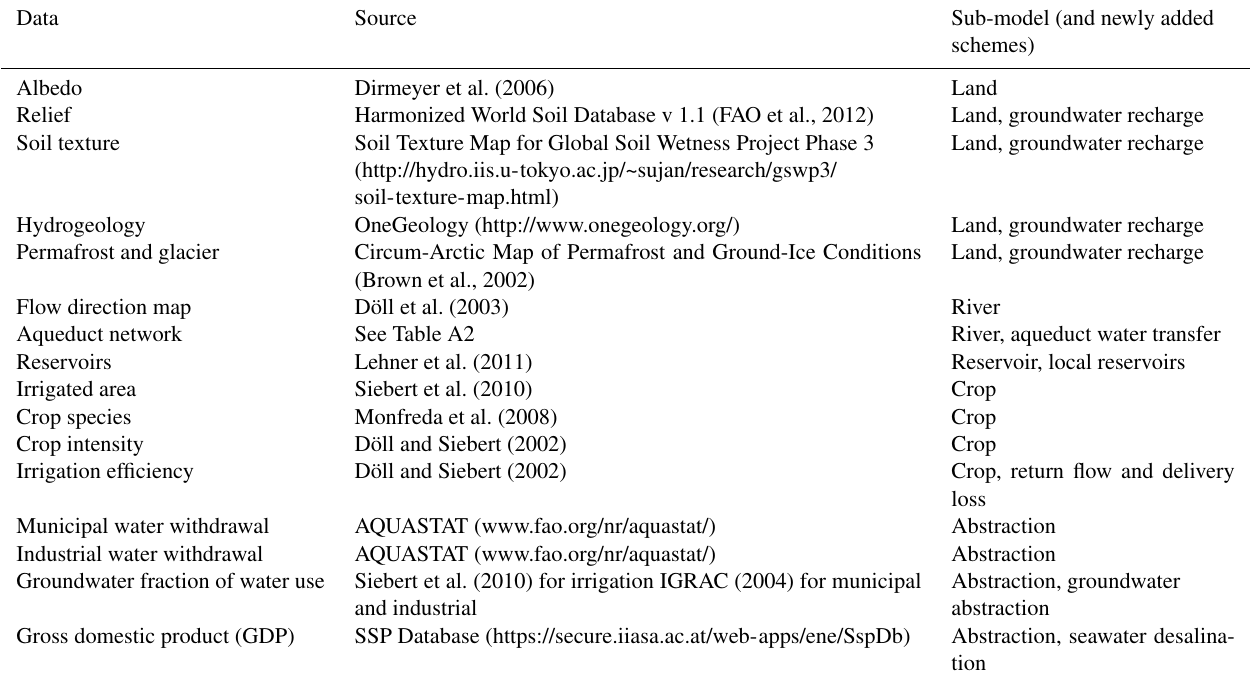
Table 1. Geographical data used in this study. Land, river, reservoir, crop, and abstraction indicate the land surface hydrology, river routing, reservoir operation, crop growth, and irrigation water requirement; these are the water abstraction sub-models of